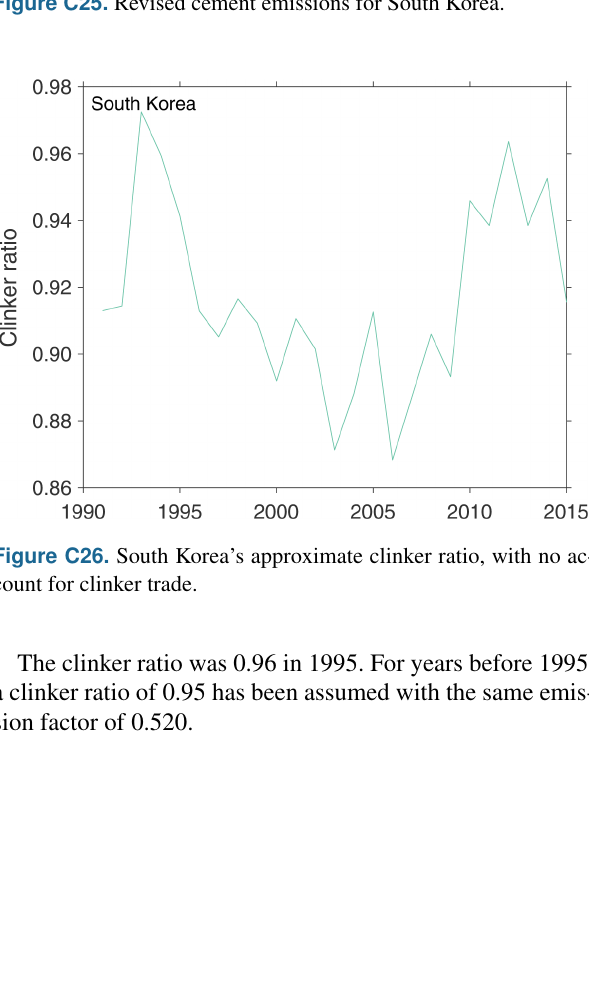
Figure C25. Revised cement emissions for South Korea.